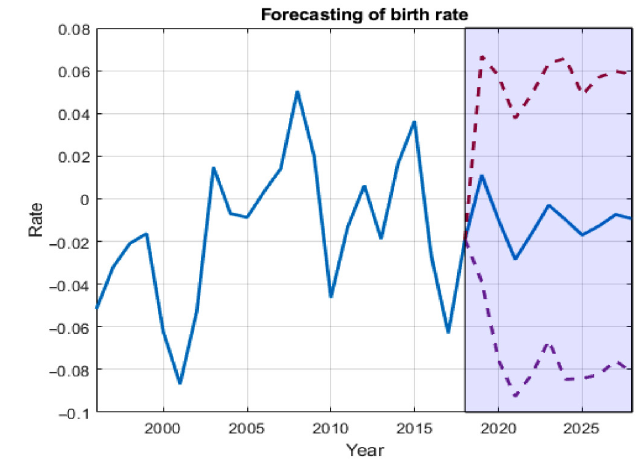
Figure 7. History and forecasting of the birth rate (source: authors’